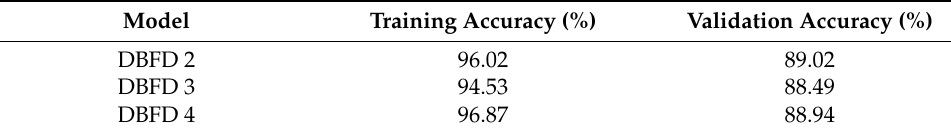
Table 8. Performance of the DBFD model under different network